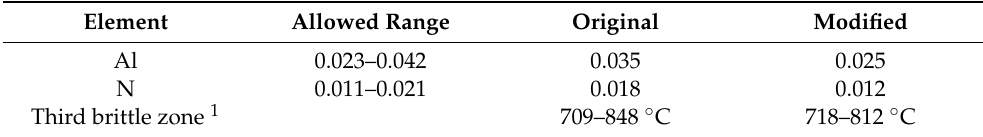
Table 5. The user-allowed composition range (wt.%), the original and modified composition, and the estimated third brittle zone of the commercial 20Cr